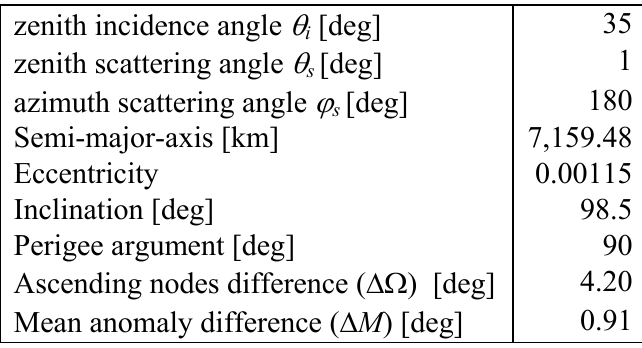
Table 2. Selected bistatic configuration (in terms of zenith incidence angle, and zenith and azimuth scattering angles), and orbital parameters at the initial epoch (static